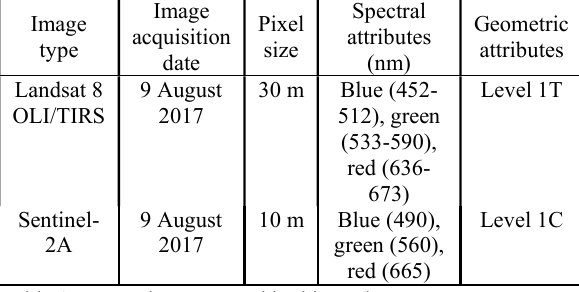
Table 1. Image data sets used in this